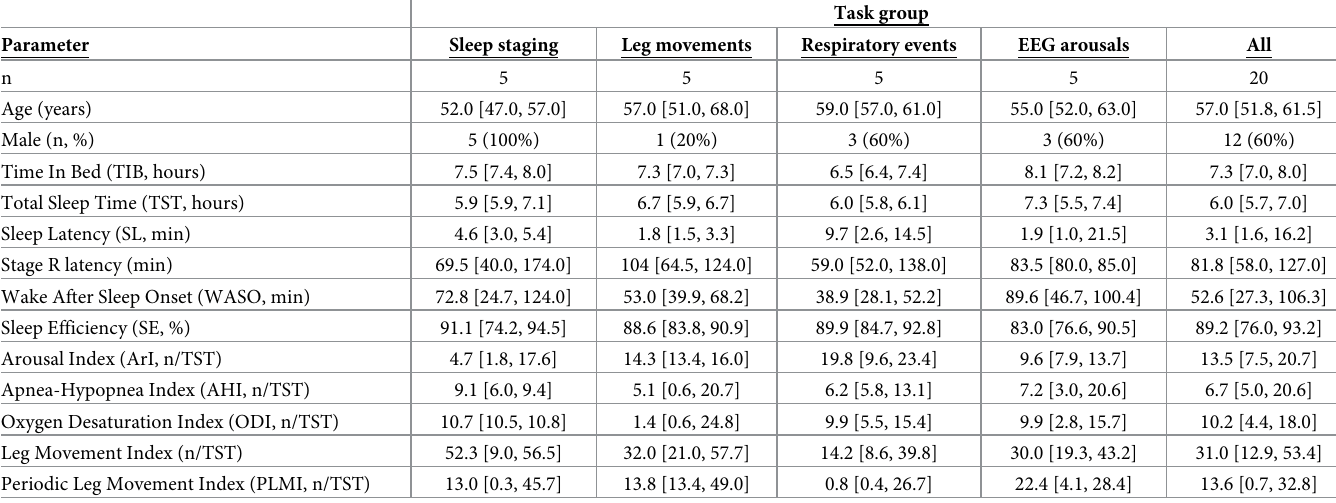
Table 1. Summary of general demographics and PSG descriptors in the study